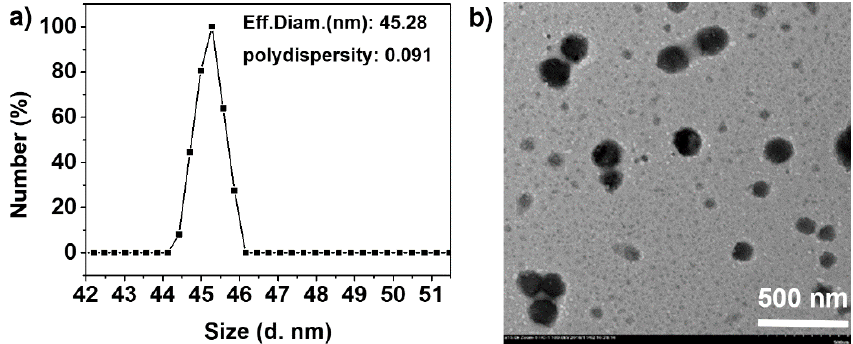
Figure 5. Assembly behavior of block polymer poly( SBL - alt - GPE )- b- poly( SBL - alt - TGE ) assemblies. ( a ) Dynamic light scattering (DLS) results of poly( SBL - alt - GPE )- b- poly( SBL - alt - TGE ) assemblies. ( b ) Transmission electron microscope (TEM) image of poly( SBL - alt - GPE )- b- poly( SBL - alt - TGE ) assemblies.